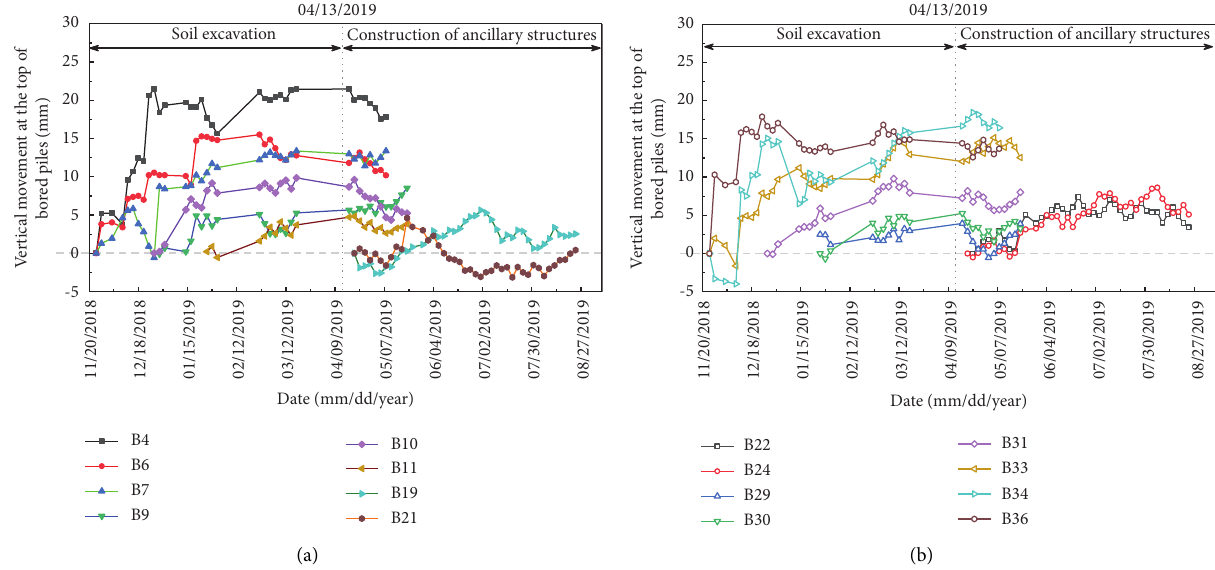
Figure 15: Distribution of the vertical movements at the top of bored piles. (a) On the north side of Zone #1 and (b) on the south side of Zone #1.